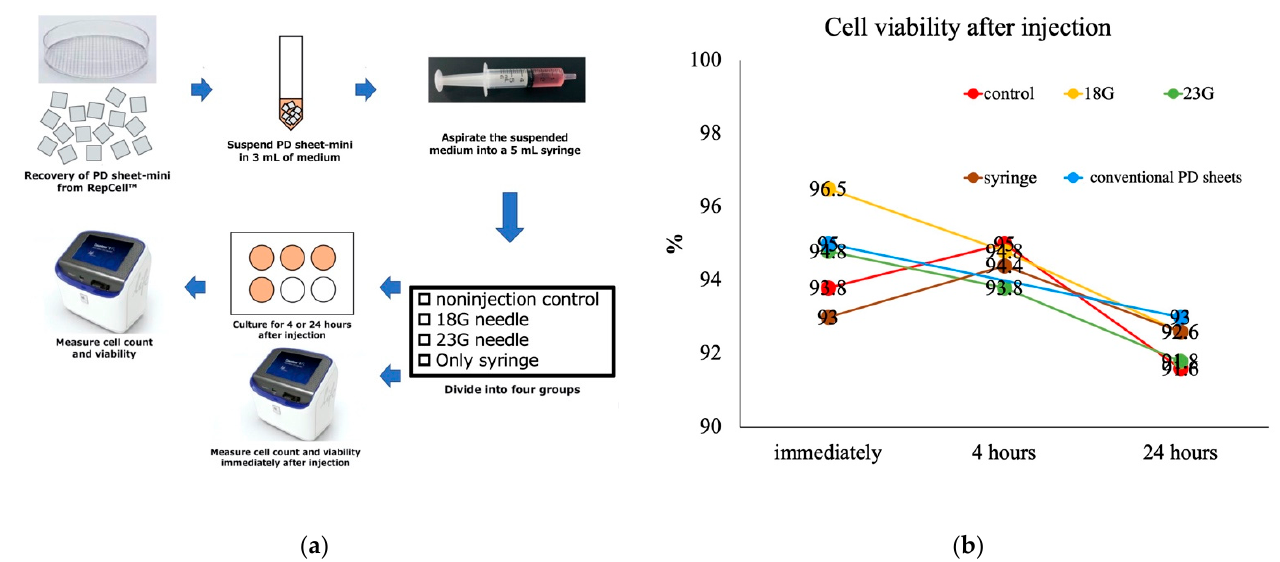
Figure 7. Evaluation of the effect of injection on cell viability of PD sheets-mini. ( a ) To examine the effect of injection on cell viability, the PD sheets-mini suspension was examined under four conditions: non-injection control, 18 gauge (G) needle injection, 23G needle injection, and syringe injection, and cell viability was measured at 0, 4, and 24 h after injection. At 0 and 4 h after injection, cell viability of conventional PD sheets was compared. ( b ) Comparison of cell viability of PD sheets-mini between the four conditions immediately after, 4 h, and 24 h after injection. Cell viability decreased with time but did not differ significantly between the four conditions at any